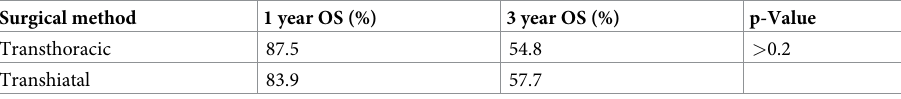
Table 4. 1 year and 3 year OS according to surgical method (time-dependent variable).